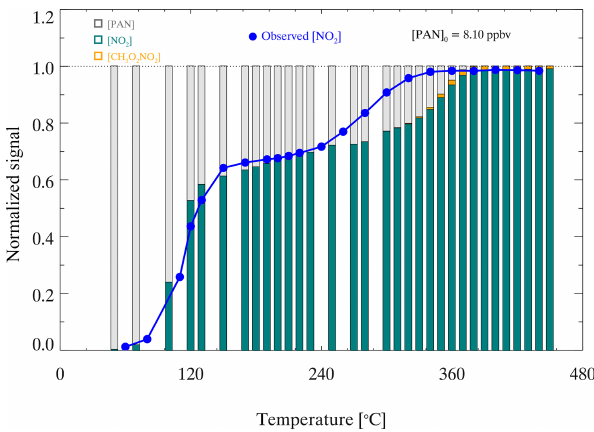
Figure 7. Normalized signals of thermal dissociation of PAN. The blue points represent the normalized signal of the observed NO 2 mixing ratio during thermal dissociation. The histogram represents the simulated distribution of thermal dissociation products at dif- ferent temperatures, in which the gray, green, and orange columns represent PAN, NO 2 , and CH 3 O 2 NO 2 ,